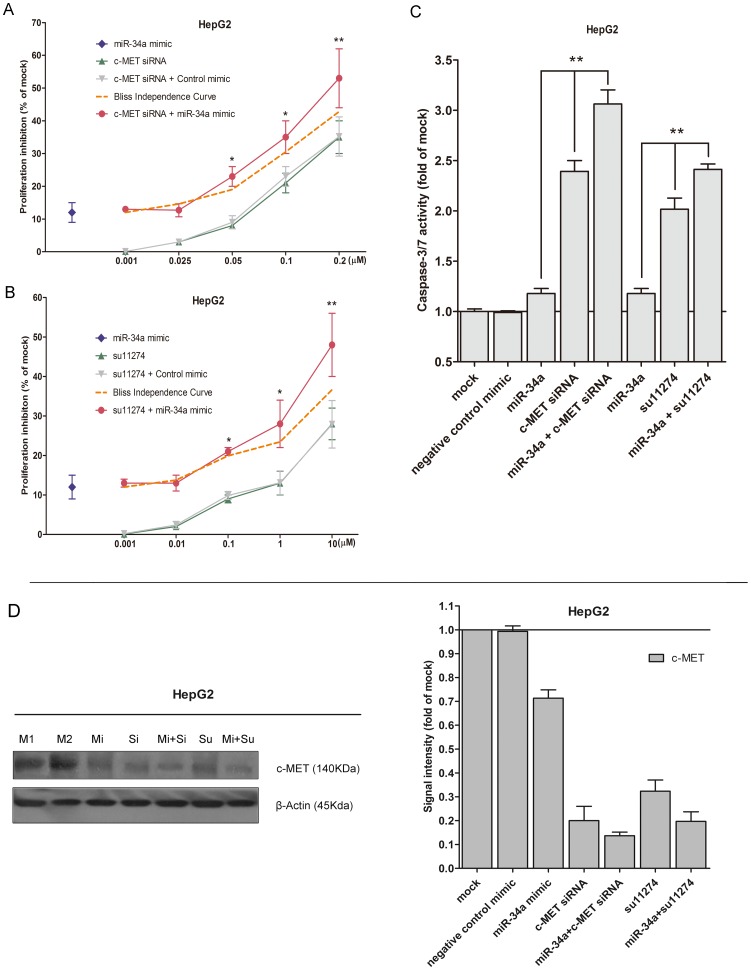
miR-34a enhanced the growth inhibitory effect of c-MET targeting agents in HCC HepG2 cells.HepG2 cells (2.5×103 cells per well in 96-well-plate) were treated with miR-34a mimic with c-MET siRNA (A) or su11274 (B). MTS was performed as Figure 2 and the proliferation inhibition rate was calculated. Bliss independence criterion was performed to calculate the theoretical additive effect. (C) Caspase-3/7 activity. * P<0.05, ** P<0.01, compared to agent alone. (D) c-MET protein level with single or dual treatments detected by western blot. Antibodies include: c-MET and β-actin.